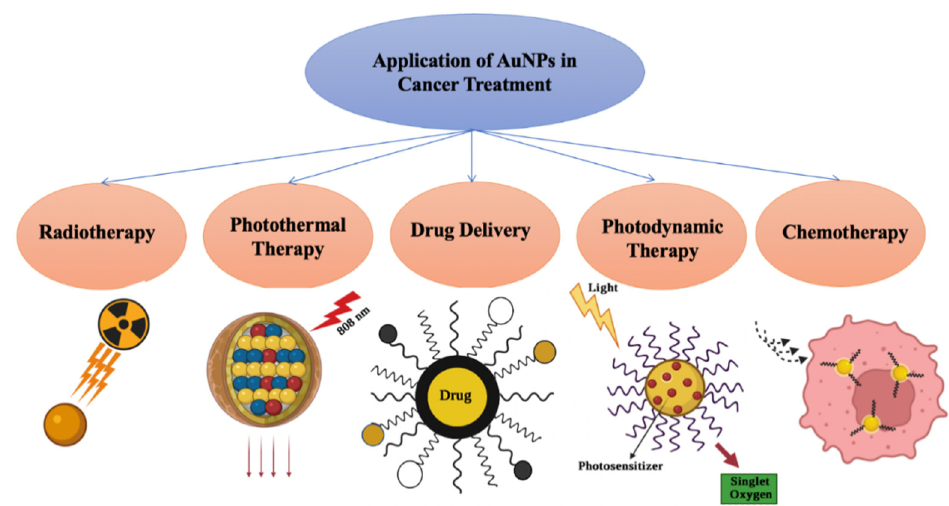
Figure 8. Various applications of AuNPs in cancer treatment.